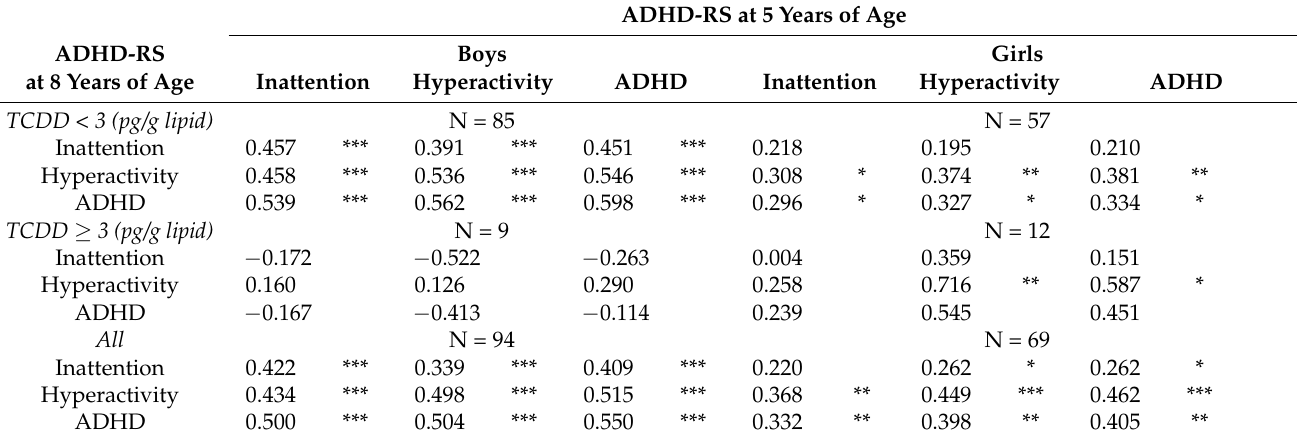
Table 4. Correlations between ADHD rating scores at 5 years and 8 years of